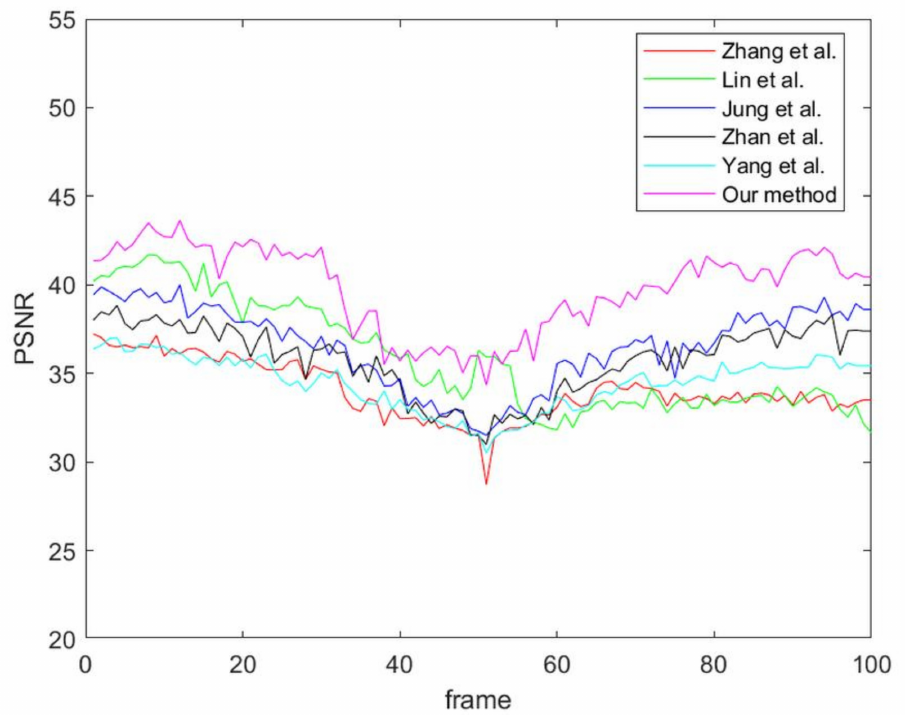
Figure 9. PSNR values for temple video clip in comparison of our proposed method, and methods of Zhang et al., Lin et al., Jung et al., Zhan et al., and Yang et al.